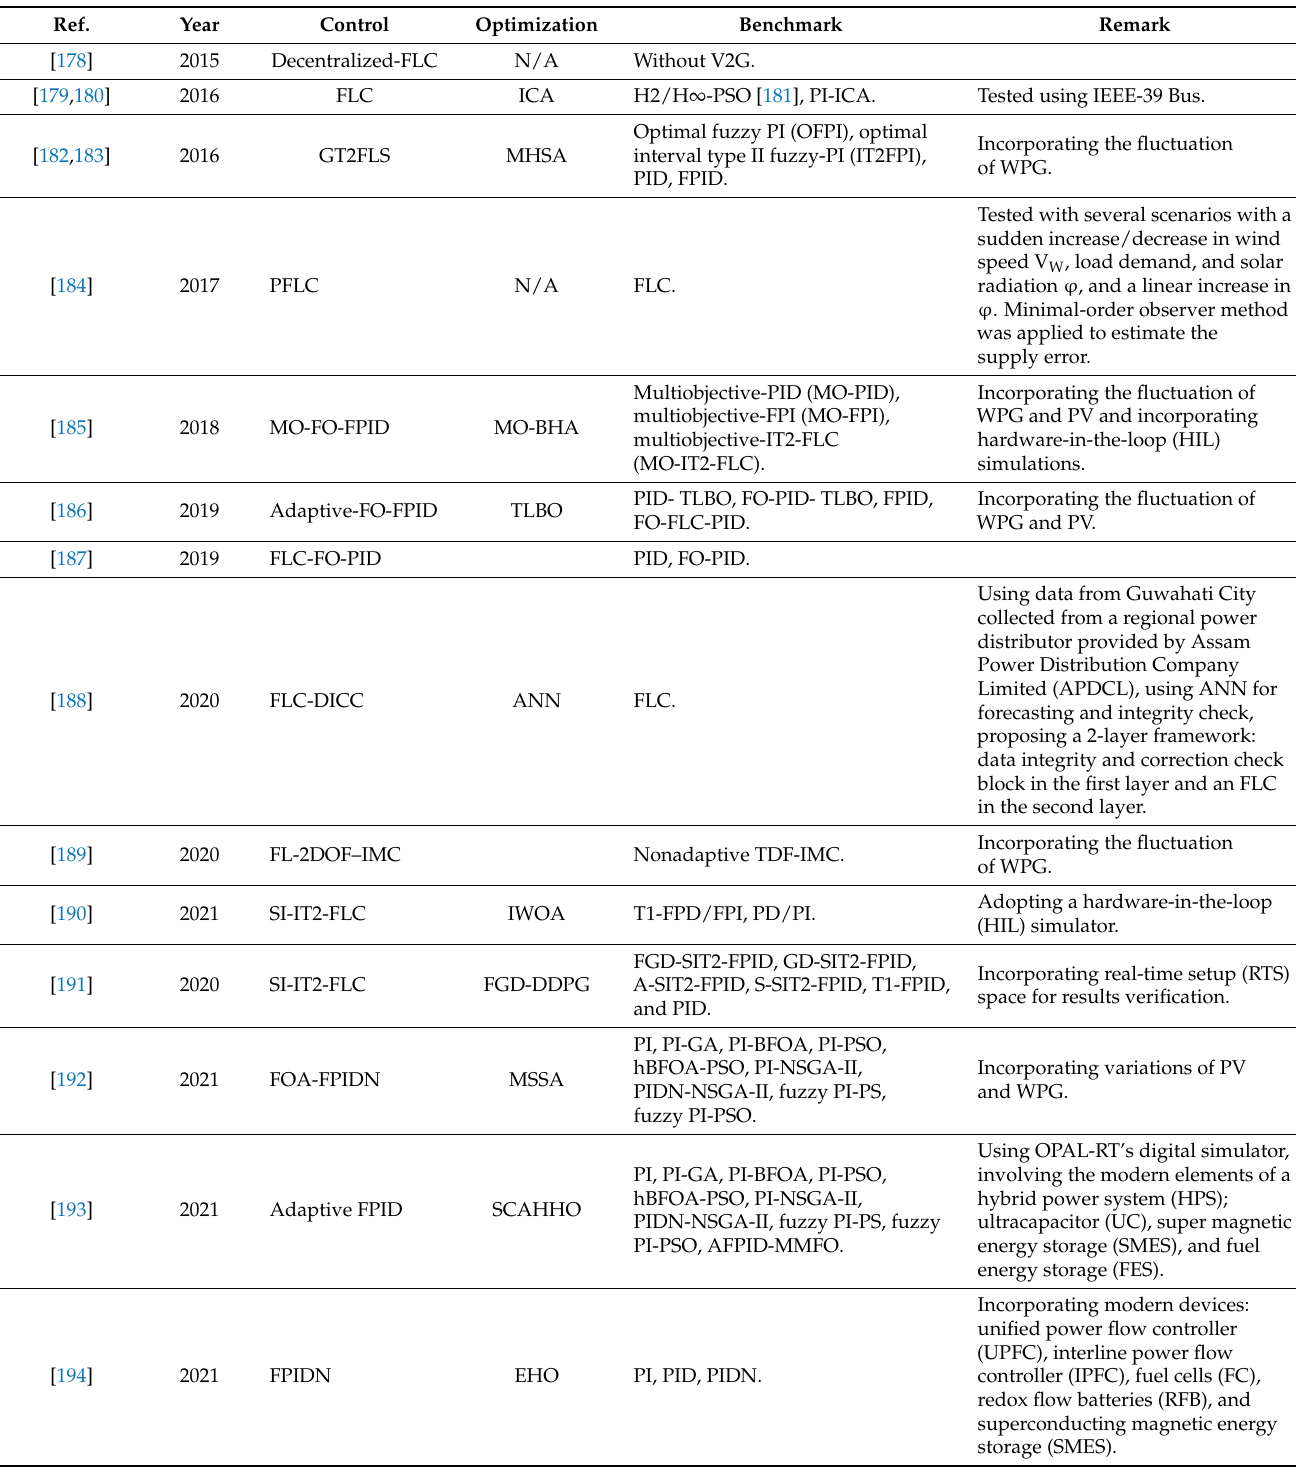
Table 3. EVAS as a frequency contingency service with fuzzy